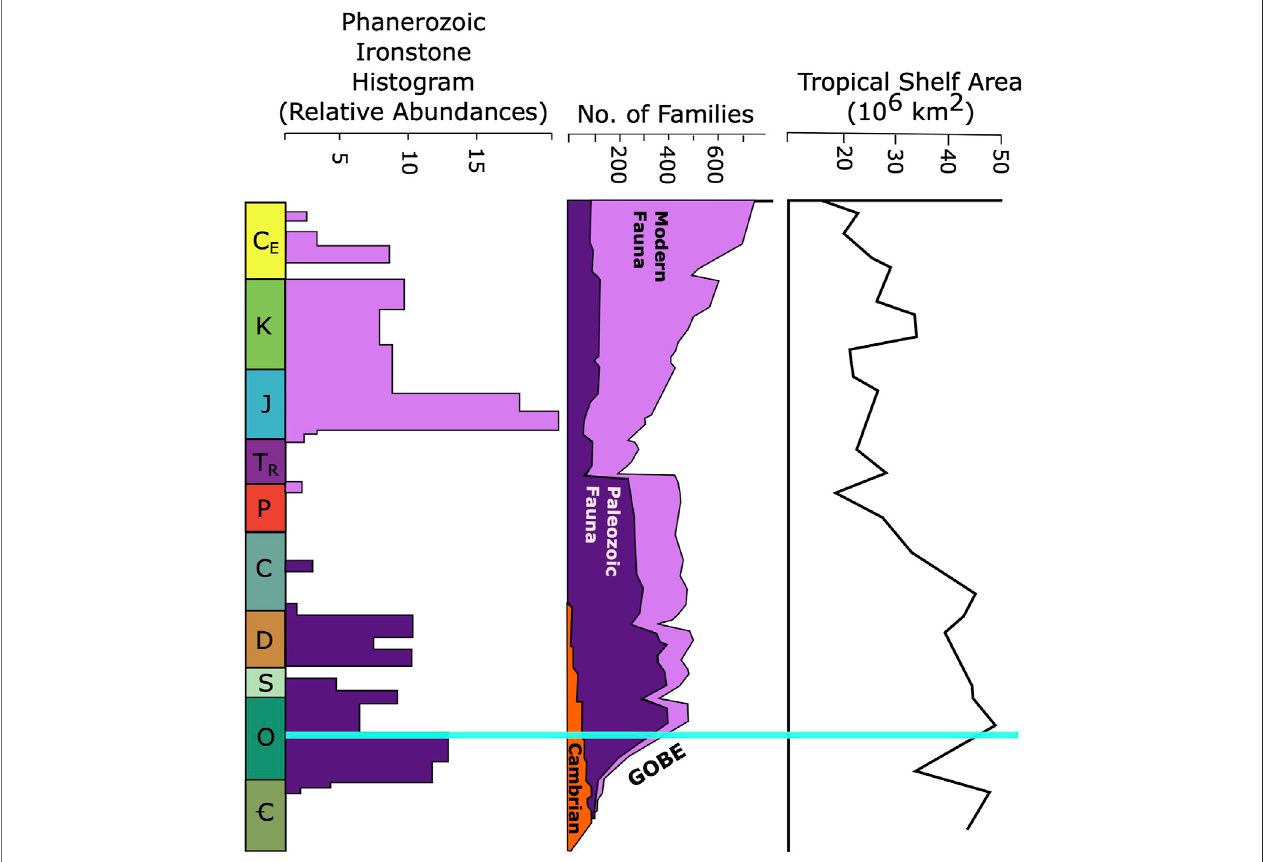
FIGURE 1 | Ironstone deposition and related biological and climatic events. Ironstone histogram (Van Houten and Bhattacharyya, 1982), “ Sepkoski ” marine invertebrate diversity curve (Servais et al., 2009), tropical shelf area (Walker et al., 2002) and global climate (James and Jones, 2016). Teal line indicates temporal occurrenceofWelshBasinironstonefromthisstudy.GOBE (cid:1) GreatOrdovicianBiodiversi fi cationEvent.ShadesofpurplehighlightthecorrelationbetweenthePaleozoic (dark purple) and Mesozoic-Cenozoic (light purple) pulses of ironstone deposition with faunal diversi fi cation.